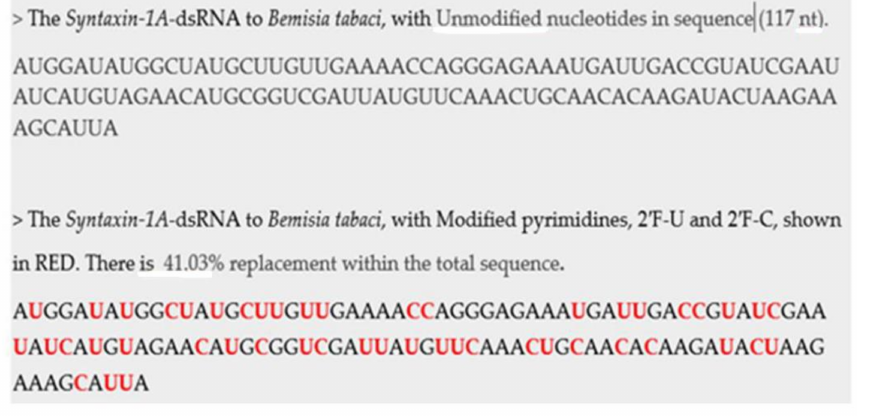
Figure 4. Example of unmodified dsRNA and modified pyrimidines, 2 (cid:48) F-C and 2 (cid:48) F-U dsRNA triggers to Syntaxin 1A , in the whitefly Bemisia tabaci. The percent of modified pyrimidines- (2’-F-C and 2’-F-U), was 41.03% of the total sequence of 117 nucleotides, but efficacy of replacement ranged from 30 to 55%. The modified, noncanonical, 2 (cid:48) -F-Cytosine and 2 (cid:48) -F-Uracil dsRNA was synthesized using the Lucigen ® DuraScribe ® T7 Transcription Kit (Cat. No.